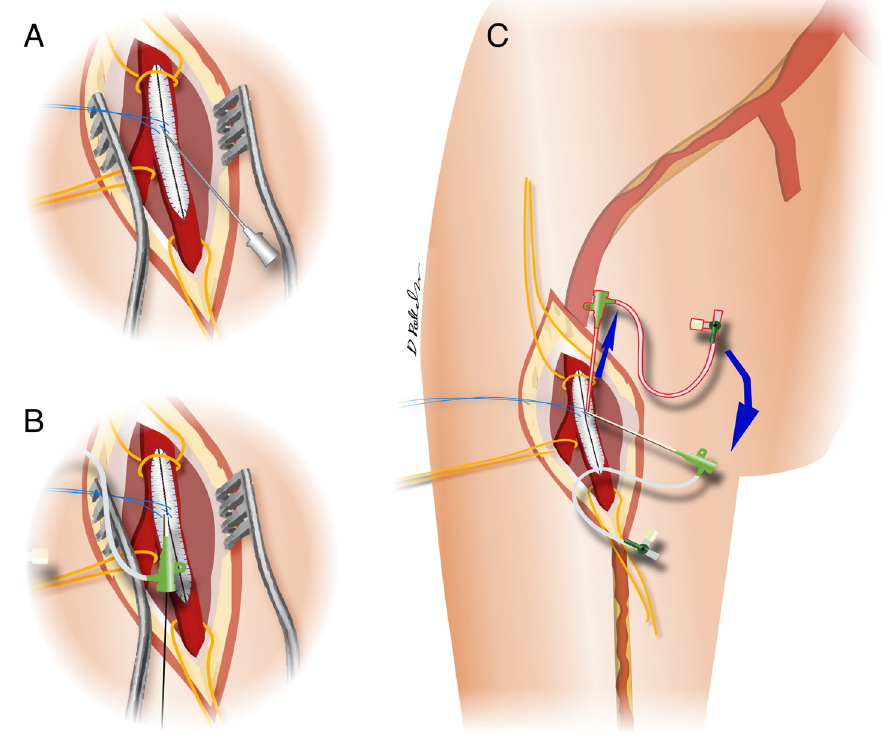
Figure 4. Drawings showing ( A ) retrograde puncture through the femoral patch in correspondence to the surgiclose “Z” shape stitch; ( B ) over the wire retrograde introducer placing to address iliac lesions; ( C ) surgiclose ‘Z’ stitch tightening with introducer removal and patch hole that was re-addressed using the introducer tip orientated in the antegrade fashion.